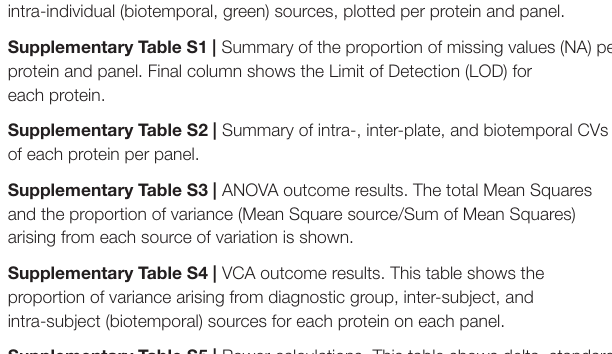
Supplementary Figure S3 | Proportion of variability in the biotemporal sample set arising from diagnostic group (purple), inter-individual (white) and intra-individual (biotemporal, green) sources, plotted per protein and panel. Supplementary Table S1 | Summary of the proportion of missing values (NA) per protein and panel. Final column shows the Limit of Detection (LOD) for each protein. Supplementary Table S2 | Summary of intra-, inter-plate, and biotemporal CVs of each protein per panel. Supplementary Table S3 | ANOVA outcome results. The total Mean Squares and the proportion of variance (Mean Square source/Sum of Mean